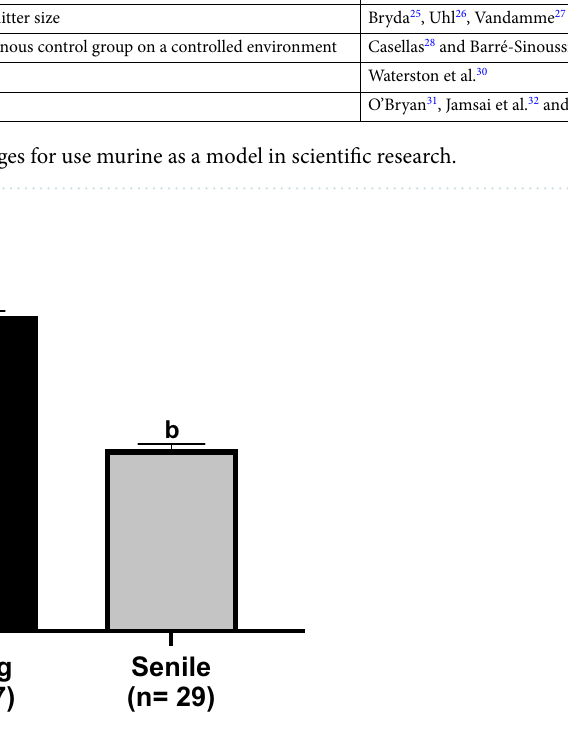
Figure 1. Mating rate. Reproductive performance of young (n = 27) and senile (n = 29) groups. Different superscript letters in each bar represent p < 0.05, as indicated by